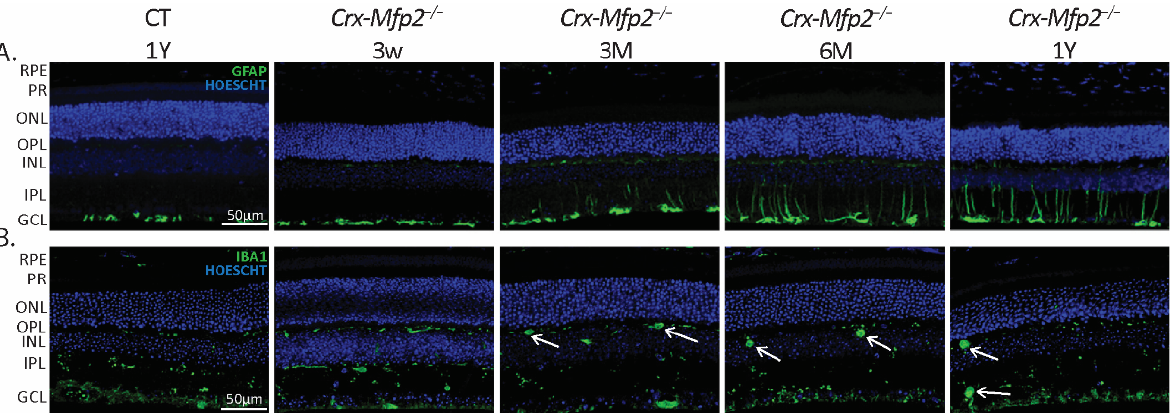
Figure 7. Retinal inflammation in the Crx-Mfp2 − / − mice. ( A ) Activated Müller cells were observed starting from the age of 3 M. Progressive sprouting into the retinal layers is observed at later time points. ( B ) Microglia infiltration is seen in the OPL already from 3 M of age. From 6 M microglia are swollen and reactive both in the OPL and IPL (white arrows). N = 4/group. RPE—retinal pigment epithelium; PR—photoreceptor layer; ONL—outer nuclear layer; OPL—outer plexiform layer; INL—inner nuclear layer; IPL—inner plexiform layer; GCL—ganglion cell layer; GFAP—glial fibril- lary acidic protein; IBA1—ionized calcium binding adaptor molecule 1.